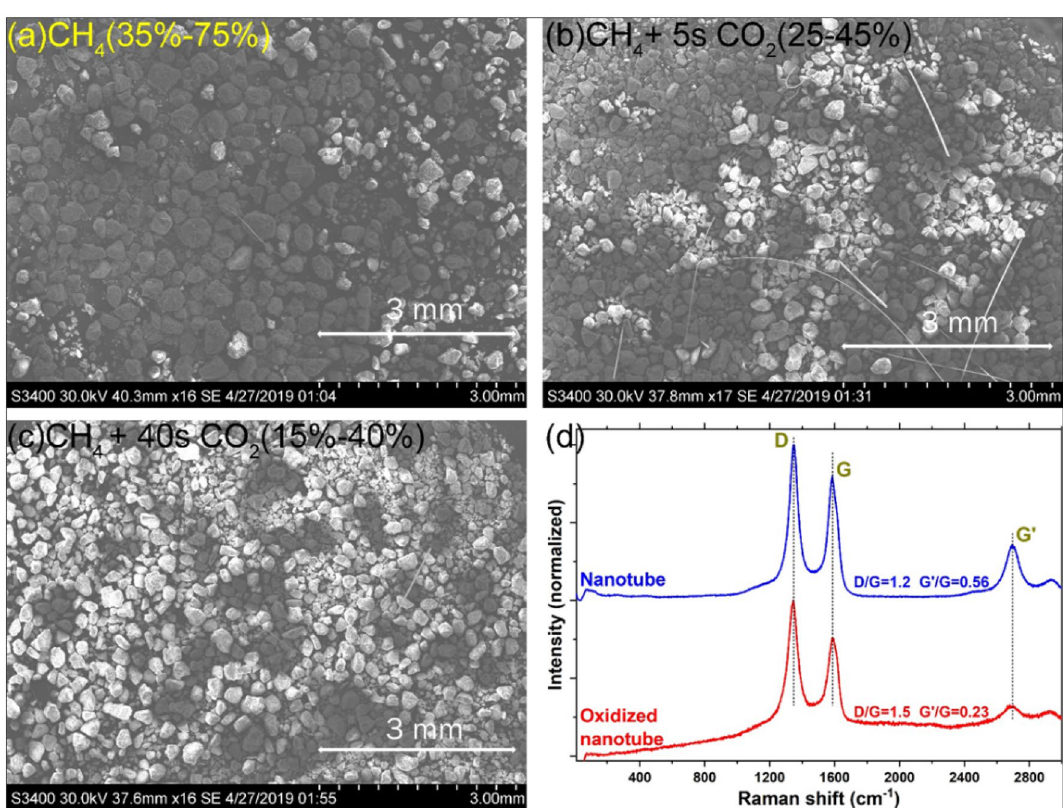
Figure 7. SEM images of ( a ) surface carbon deposited continuously from room temperature to 700 °C during CH 4 pyrolysis, which undergoes oxidation by ( b ) a 5 s-CO 2 pulse or ( c ) a 40 s CO 2 pulse. ( d ) Raman spectra of MWCNT without and with the 40 s-CO 2